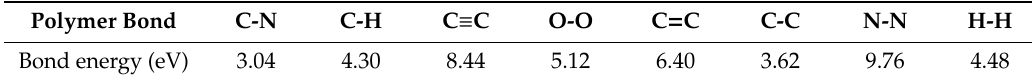
Table 2. Chemical bond energies for polymers.